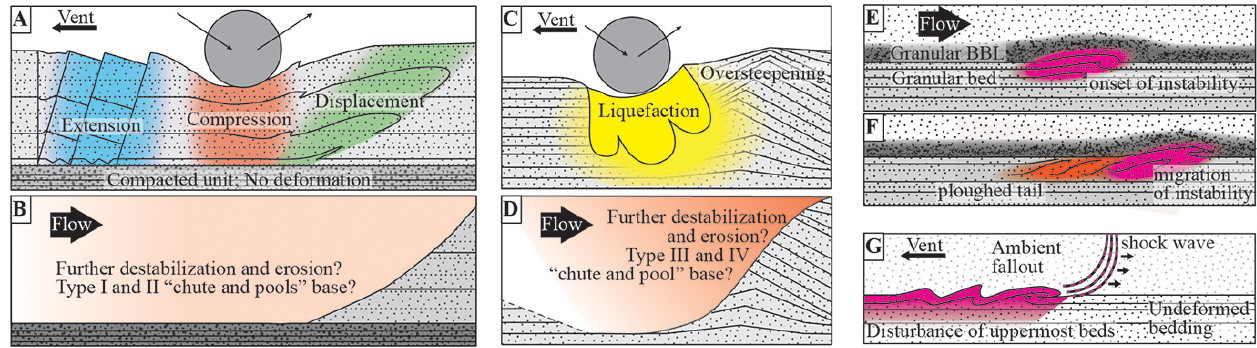
Figure 7. Interpretative sketch of syn-eruptive SSD. (a) and (c) SSD formed by ballistic impacts. Panels (b) and (d) show the envisaged scenario if destabilization of a and c permitted complete remobilization. These would form the base for types I and II “chute and pool” structures in Schmincke et al. (1973). (e) Formation of pseudo Kelvin Helmholtz instabilities between the bed and basal granular flow, and (f) the ploughing effect of a migrating instability. (g) Destabilization by shock